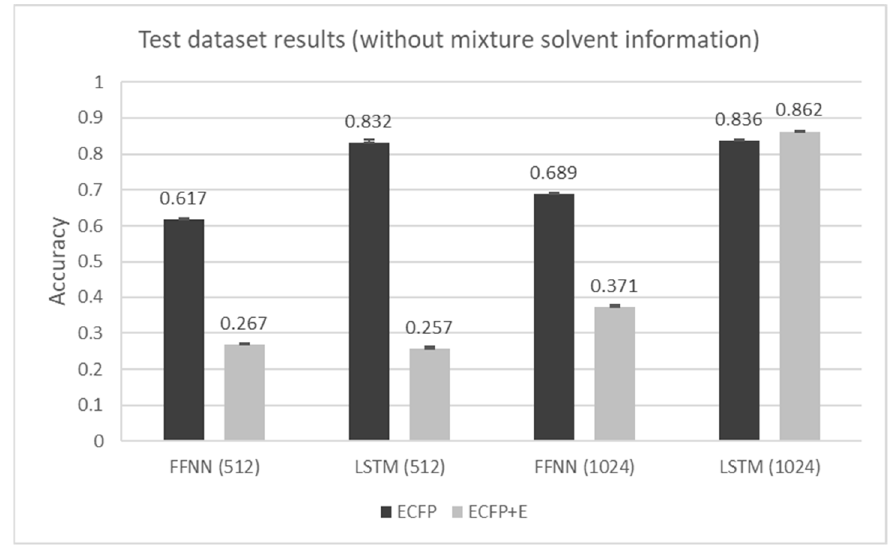
Figure 3. Visual representation of the accuracy values on DS1.